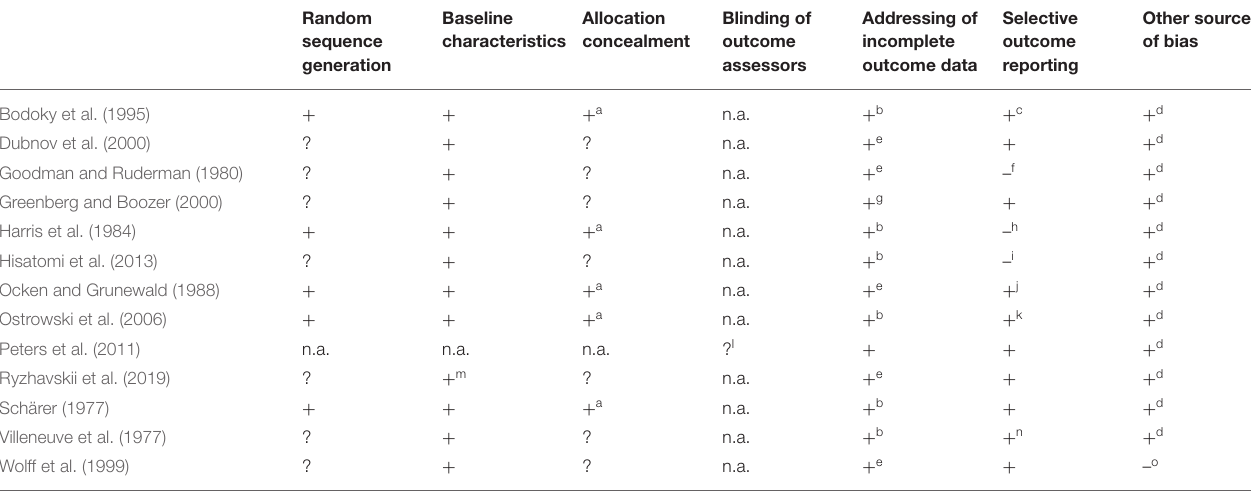
TABLE 2 | Risk of bias assessment.